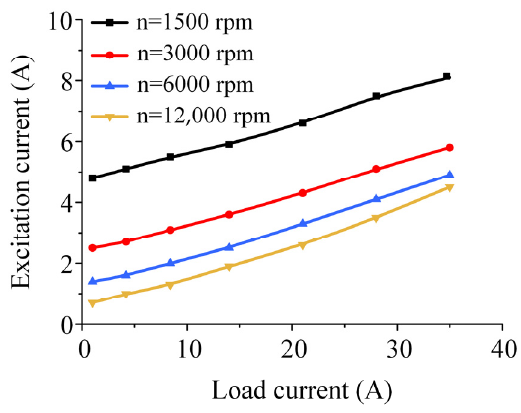
Figure 14. Curves of adjustment characteristics.